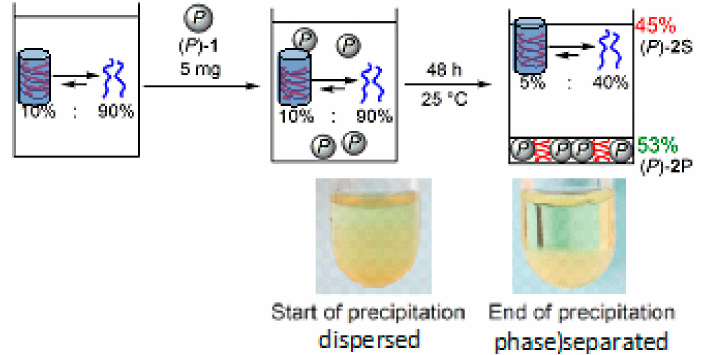
Figure 34. Molecular recognition of homo-double-helices by heliciene-grafted silica nanoparticles, Figure 6.Shape recognition ofhetero-double-helix,random -coil,and hetero-